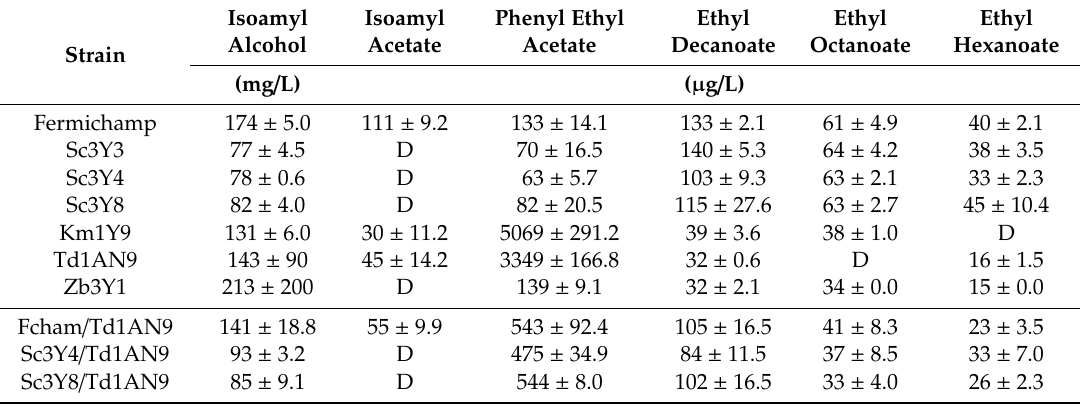
Figure 4. Population kinetics on grape juice medium for the three Saccharomyces cerevisiae / Torulaspora delbrueckii mixed inoculum tested: ( A ) Sc3Y4/Td1AN9, ( B ) Sc3Y8/Td1AN9 and ( C ) Fermichamp/Td1AN9; Markers show: (−Ж−) total cells count, (− −) viable cell count, both determined by a Neubauer chamber without or with methylene blue, respectively; (−O−) S. cerevisiae colonies count, and (−●−) T. delbrueckii colonies count, determined by solid (WL Differential and WL Nutrient) media. As data is presented in logarithmic scale, standard deviation bars are masked by marker size. Table 6. Main volatile compounds profiles of the selected Saccharomyces and non- Saccharomyces yeasts fermenting individually (upper panel) or as a mixed culture (bottom panel) in grape juice medium at a sugar concentration of 137 g / L initial glucose and 119 g / L initial fructose, data at 144 h of